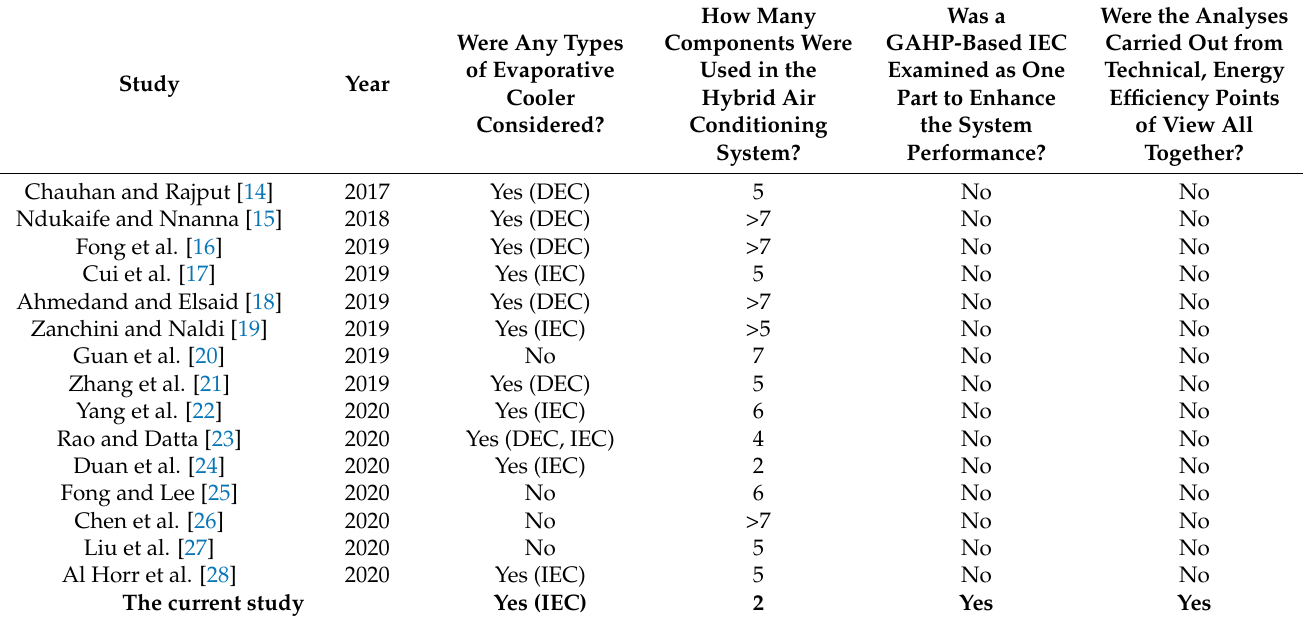
Table 1. Recent investigations have been performed in the field of hybrid air conditioning